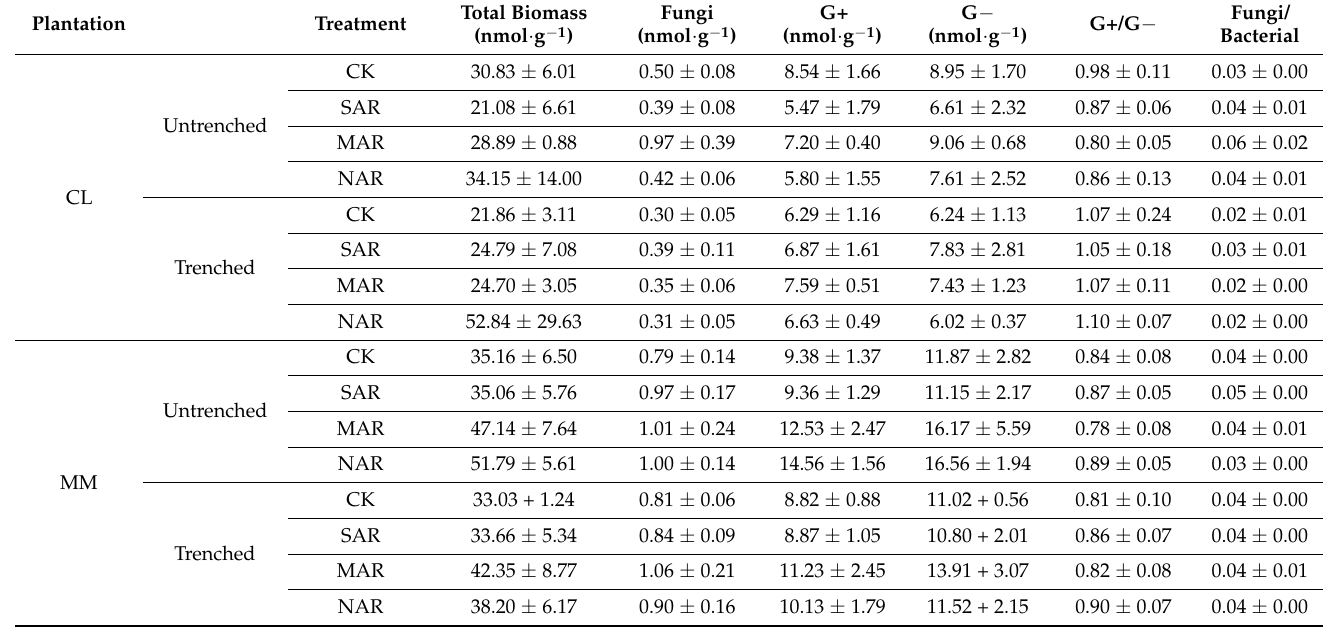
Table 3. Variations in soil microbial PLFAs under different types of acid rain in Cunninghamia lanceolata (Lamb.) Hook. (CL) and Michelia macclurei Dandy (MM) plantations. Data are the mean ± standard error ( n = 4). The absence of letters indicates no significant differences among acid rain